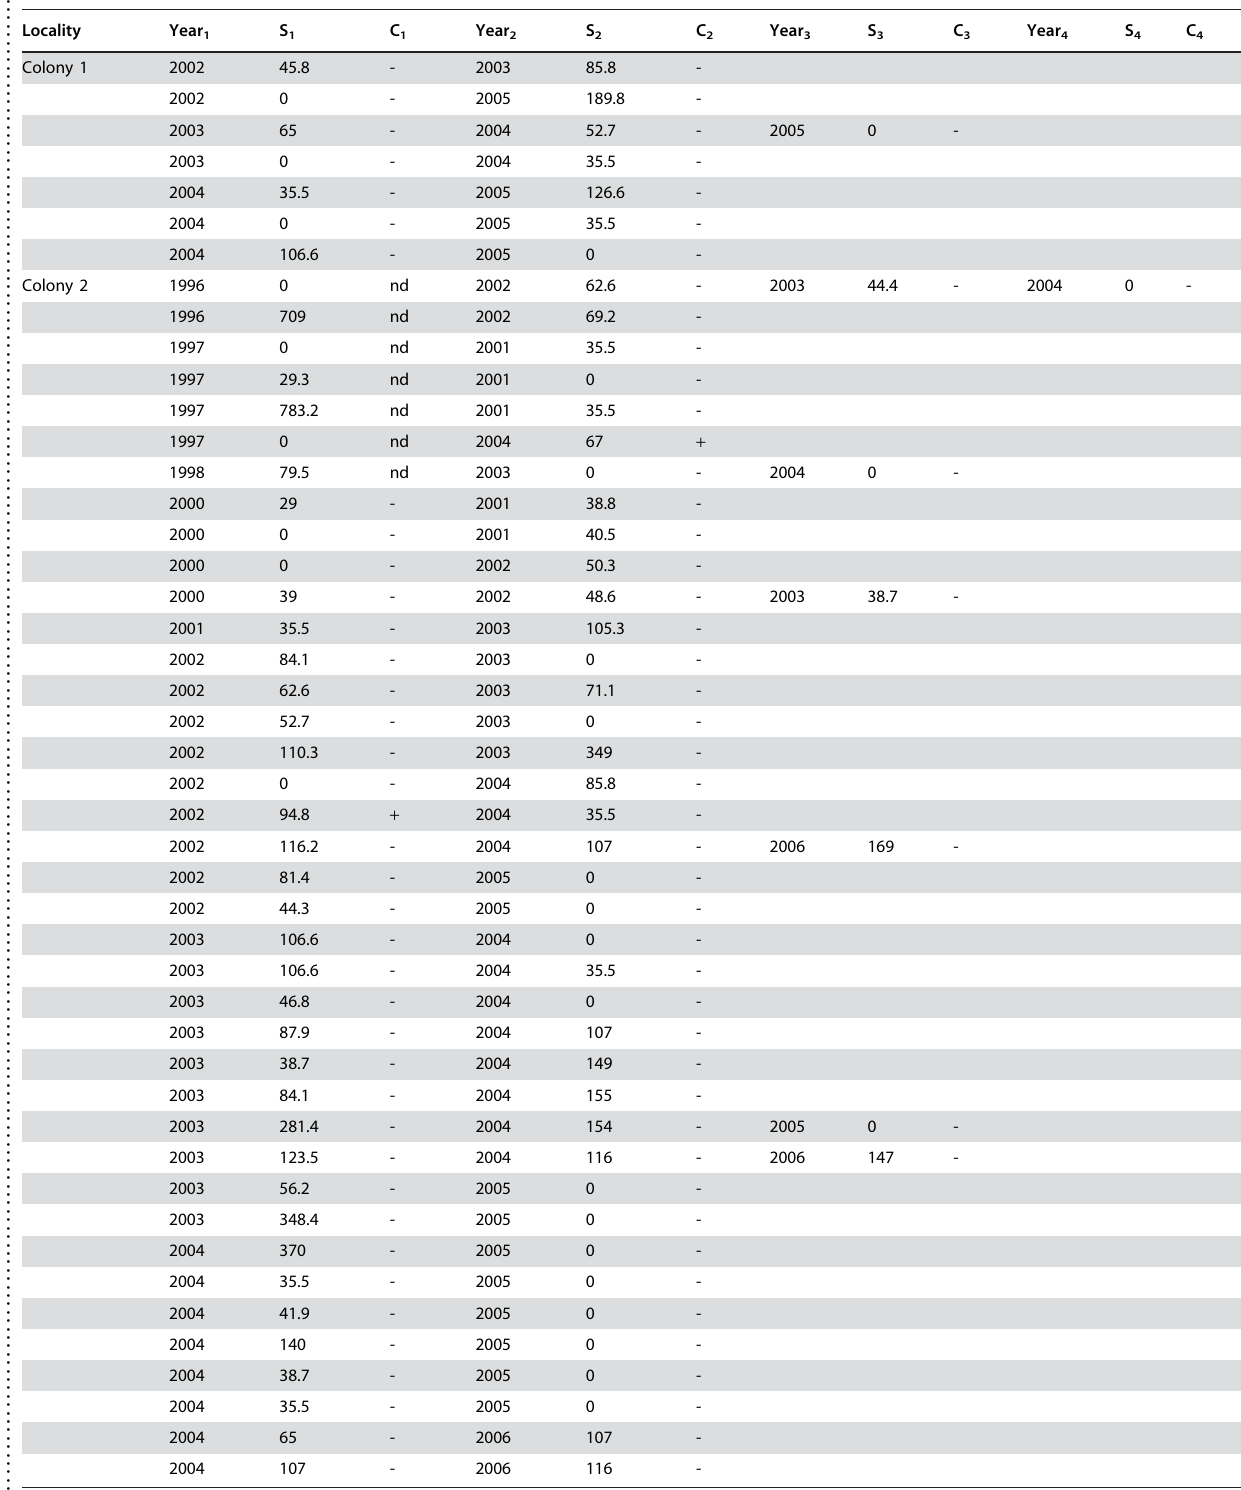
Table 2. Individual Serological Follow-up in Recaptured Bats. .. ... .... ... ... .... ... ... .... ... ... .... ... ... .... ... ... .... ... ... .... ... ... .... ... ... .... ... ... .... ... ... .... ... ... .... ... ... .... ... ... .... ... ... .